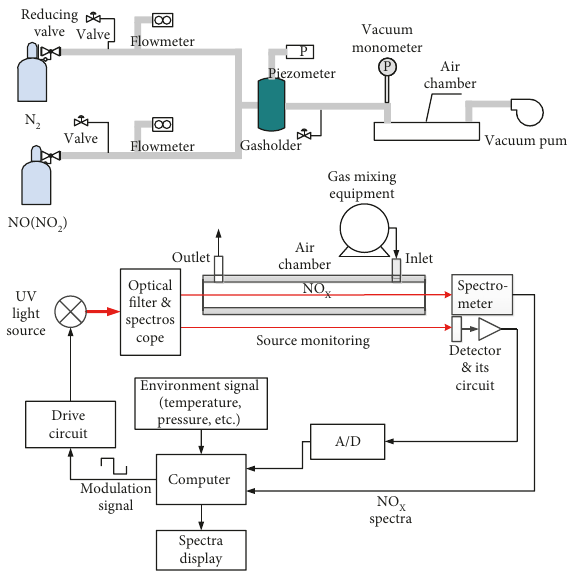
Figure 1: Schematic diagram of the experimental platform with its gas mixing equipment for NO